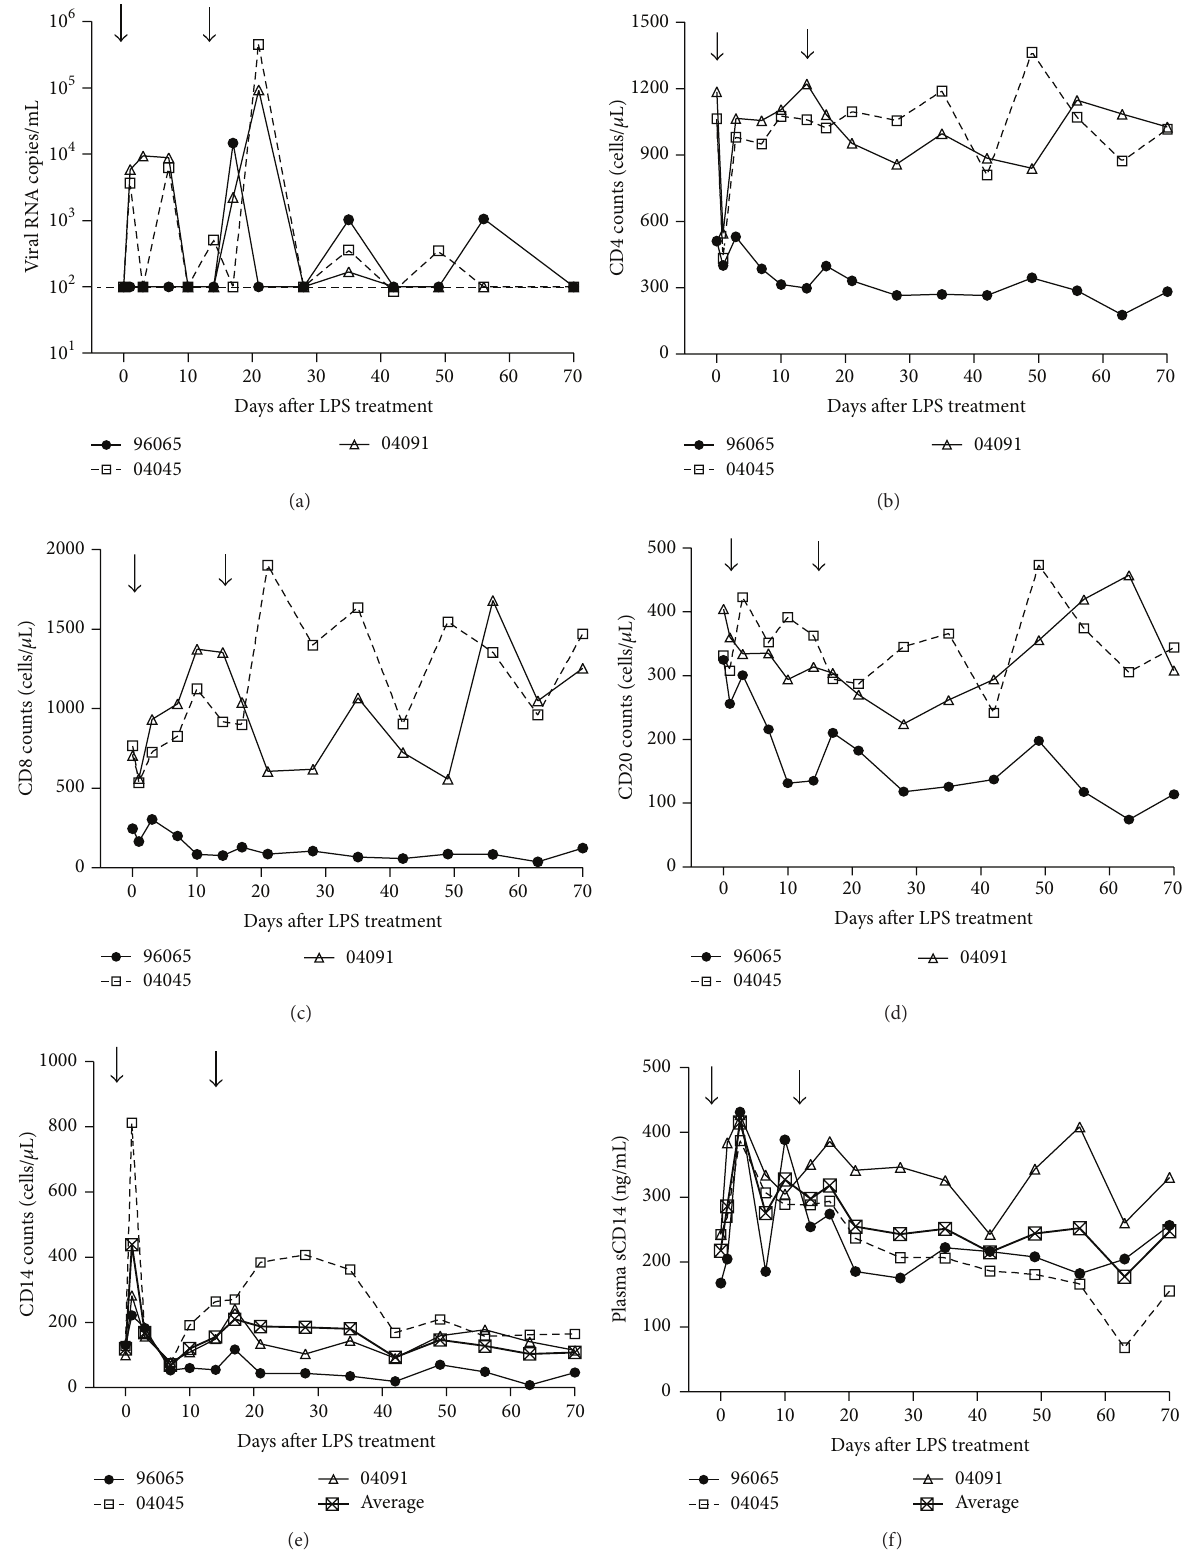
Figure 2: LPS administration in chronically SHIV -infected Ch-RMs. LPS induces a transient increase in the VL. The dashed line B’WHU indicates the limit of detection at 100copies/mL plasma (a), a transient decrease in the absolute number of CD4 + T cells (b), an increase in CD8 + T cells (c), a decrease in CD20 + B cells (d), an increase in levels of CD14 + cells (e), and an increase in plasma sCD14 (f). Ch-RMs were intravenously injected twice with LPS at 50 𝜇 g/kg body weight at day 0 and day 14